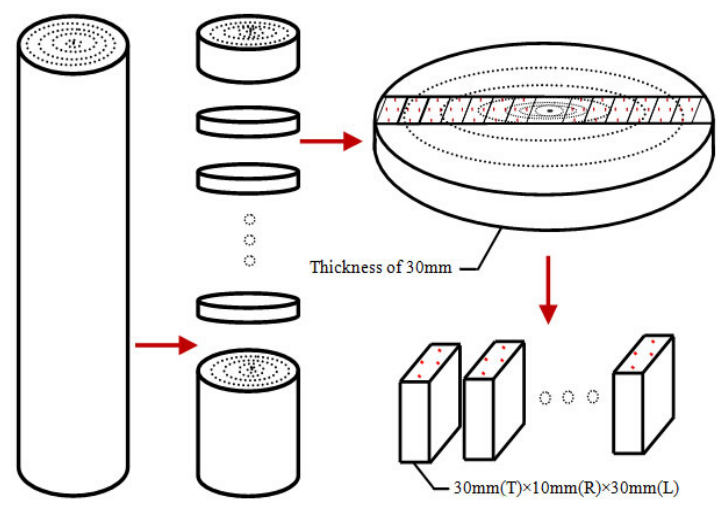
Figure 1. Cutting diagram of moisture content and strain slices. T indicates a tangential measurement; R, radial; L, longitudinal.